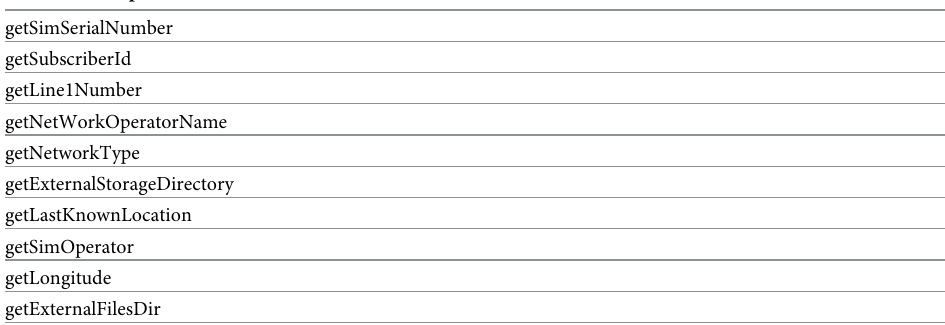
Table 8. The top ten API calls of TF-IDF difference.